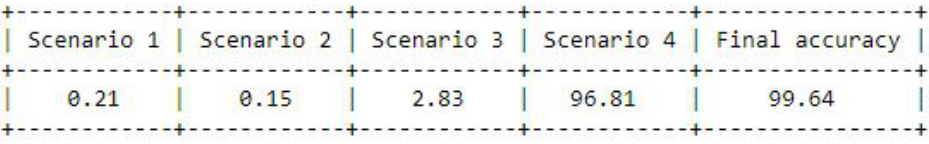
Figure 18. Experimental final accuracy for blood pressure